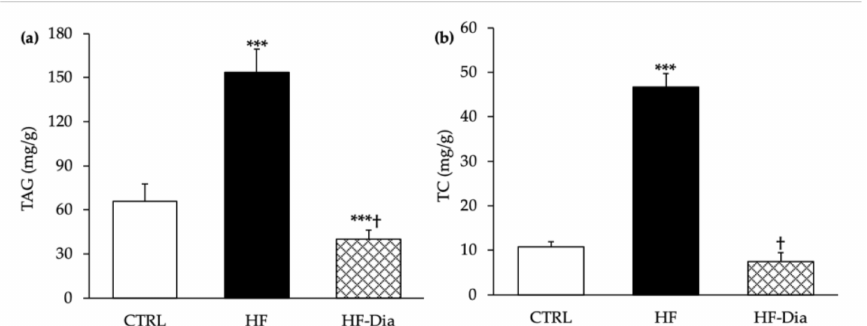
Figure 5. Effects of D. lutheri supplementation on liver triglyceride ( a ) and cholesterol ( b ) levels. CTRL, control group; HF, high-fat group; HF-Dia, high-fat group supplemented with D. lutheri ; TAG, triacylglycerol; TC, total cholesterol. Values are means (n = 6), with standard deviations represented by vertical bars. Statistical significance was determined using ANOVA with post hoc Fisher’s test and mean values were significantly different from those of the CTRL group with *** p < 0.001. † Significant difference compared with the HF group ( p <